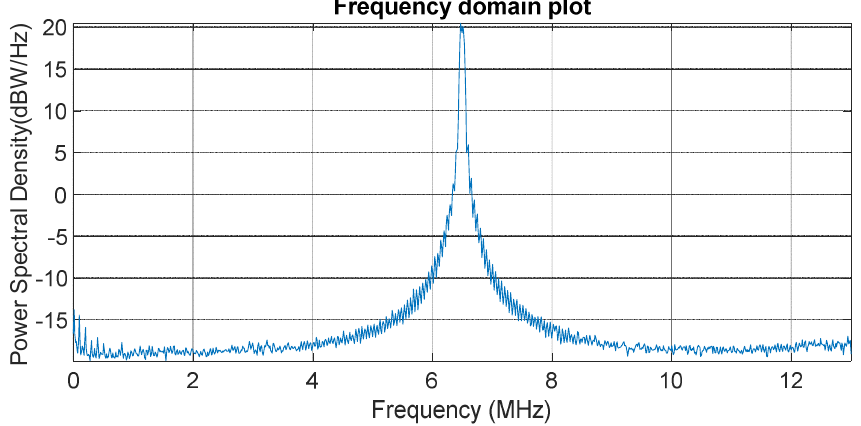
Figure 22. Frequency spectrum of VHDL implementation (fixed-point with 8-precision).